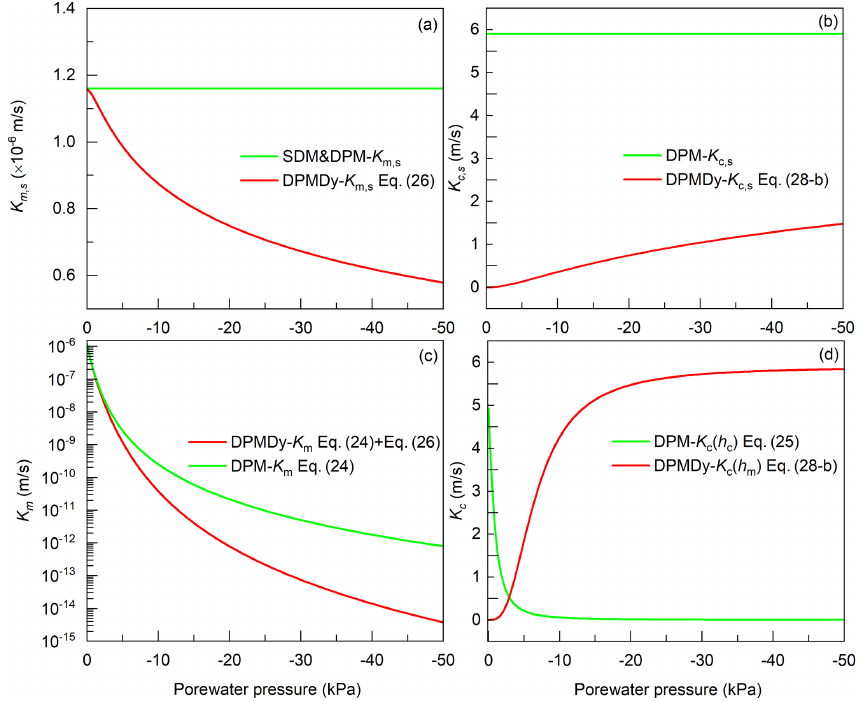
Figure 12. Modeled hydraulic conductivity of each domain in the three models. (a) Saturated hydraulic conductivity of the matrix domain, (b) saturated hydraulic conductivity of the crack domain, (c) transient hydraulic conductivity of the matrix domain and (d) transient hydraulic conductivity of the crack domain.